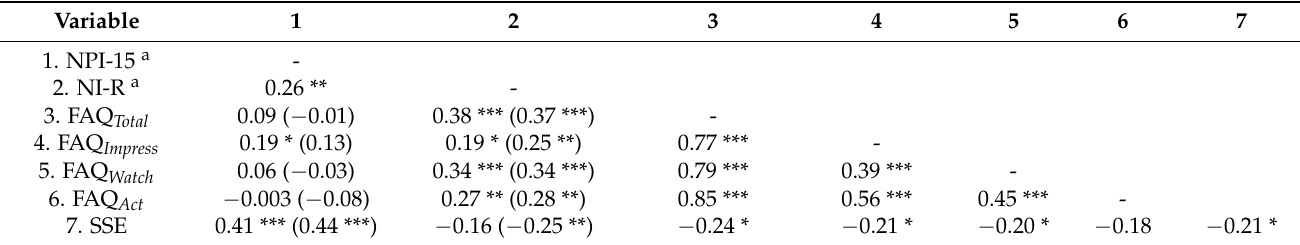
Table 2. (Partial) correlations among the